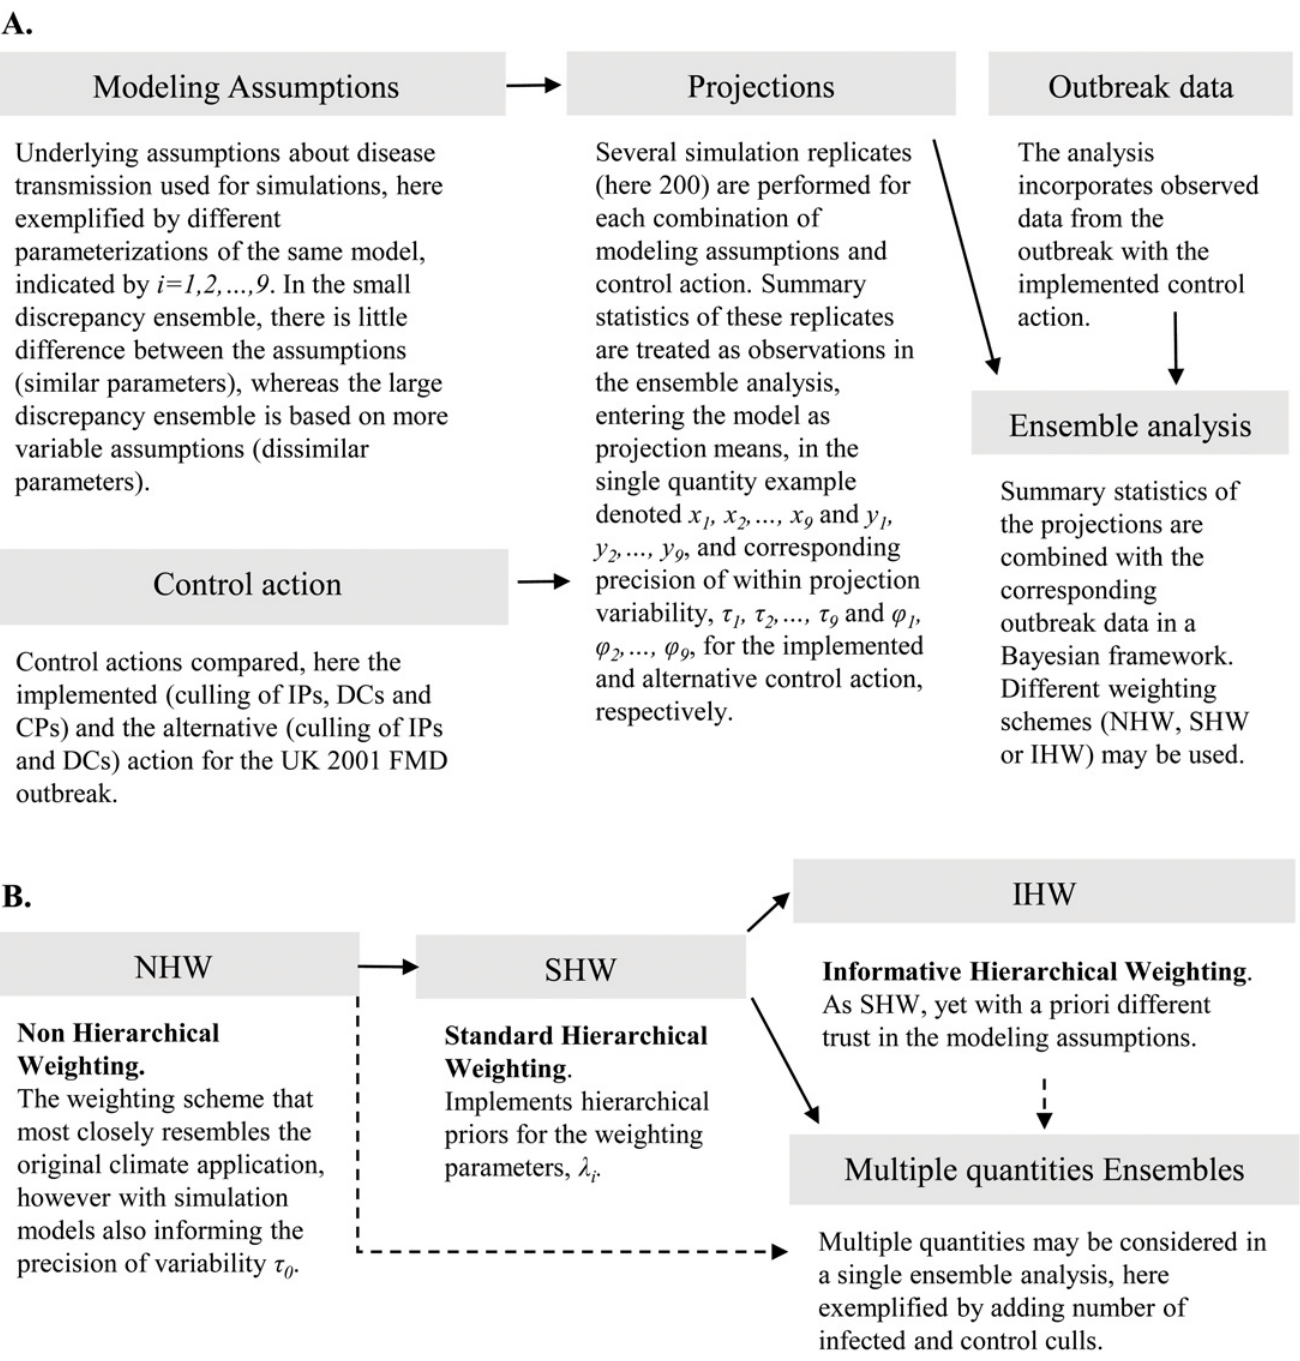
Fig 1. Overview of analyses and methods developments. Panel A presents a conceptual flowchart, showing that modeling assumptions are combined with control actions to simulate projections. These are then combined with observed outbreak data in the ensemble analysis. Panel B presents the methods developments in this study, indicating that we start with the Non Hierarchical Weighting (NHW) scheme, which is most similar to the original climate application. We then extend this to the Standard Hierarchical Weighting (SHW) scheme, and subsequently to Informative Hierarchical Weighting (IHW). We also extend the analysis to consider multiple epidemic quantities. The dashed lines indicate combinations for which the method and the supplied algorithm (S1 File) can be used but are not treated explicitly in the presented examples.